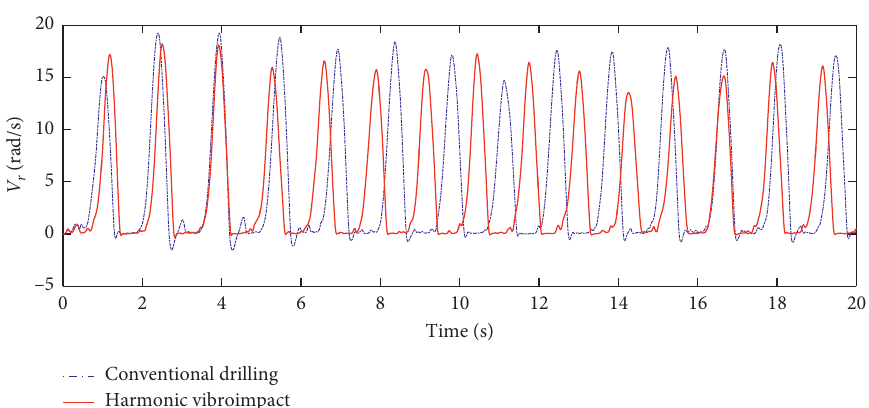
Figure 11: Time-history curves of angular velocity under different drilling